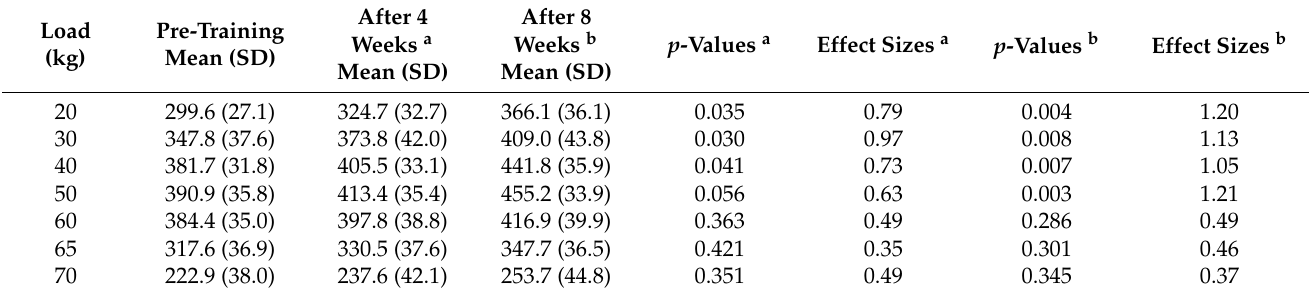
Table 1. Mean power (W) during chest presses on a Swiss ball prior to and after 4 and 8 weeks of instability resistance training.